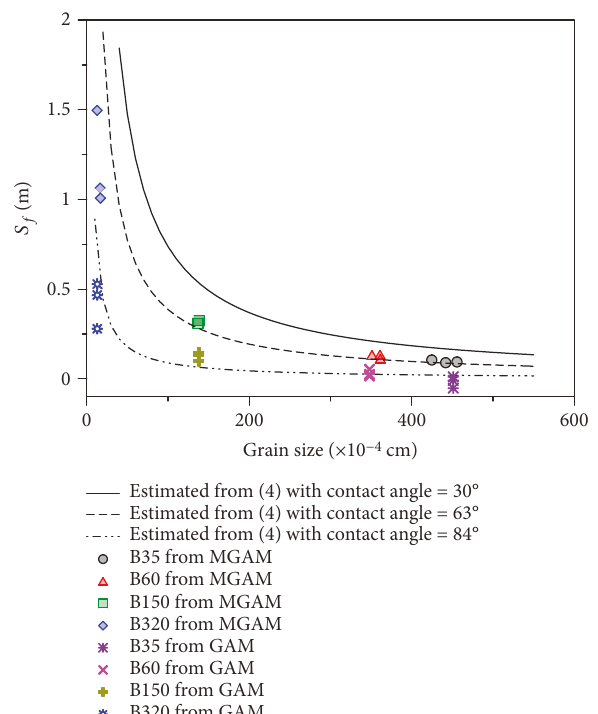
Figure 7: Wetting front suction head s from MGAM was larger than s sands, s f curve estimates s from a static contact angle of 30 ° , the dotted f line represents the best contact angle (63 ° ) with s and the dashed-dotted line represents the contact angle =84 ° with from s f